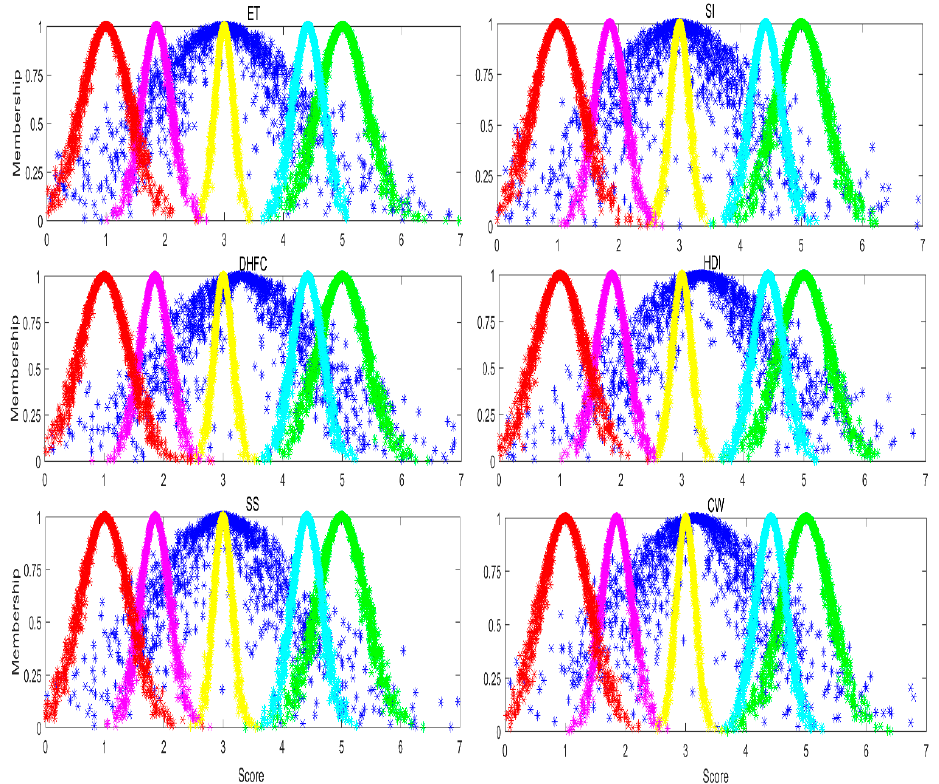
Figure 3. Comparison of indicator cloud models and corresponding standard cloud model. Red, pink, yellow, cyan and green standard cloud model indicate Dangerous, Relatively dangerous, Generally safe, Relatively safe and Safe levels, respectively. Cloud models of evaluation indicators marked in blue. All the cloud images consist of 1000 cloud drops.